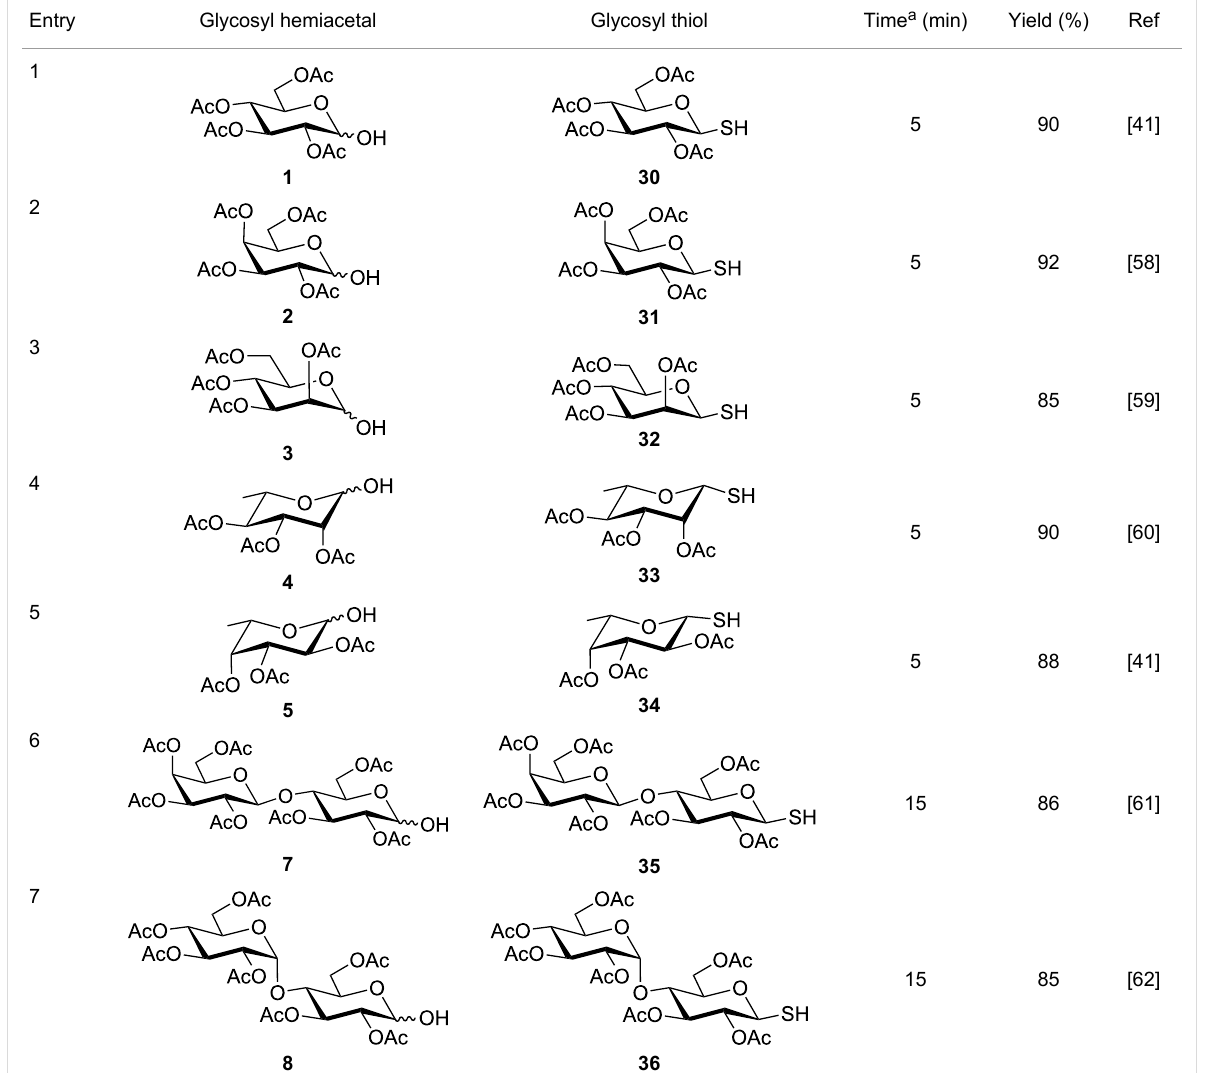
Table 4: Appel-reagent-mediated transformation of glycosyl hemiacetal derivatives to glycosyl thiol derivatives at room temperature.